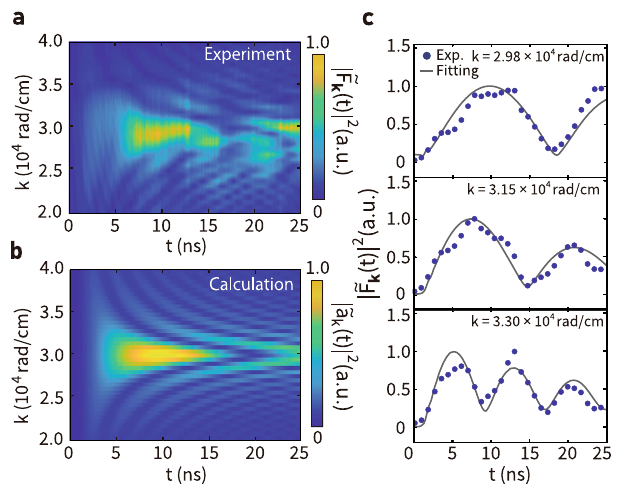
Fig. 4 Parameter fi tting of coherent oscillation. a Experimentally obtained ð t Þj 2 at B = 11.5 mT. b Calculated temporal temporal evolution of j ~ F k evolution of magnon amplitude j ~ a k ð t Þj 2 . c Temporal evolution of j ~ F k ð t Þj 2 at different wavenumbers. Gray curves represents fi tting curves according to Eq. (3). Errors of the data are evaluated as a standard deviation, which is smaller than the data plot.